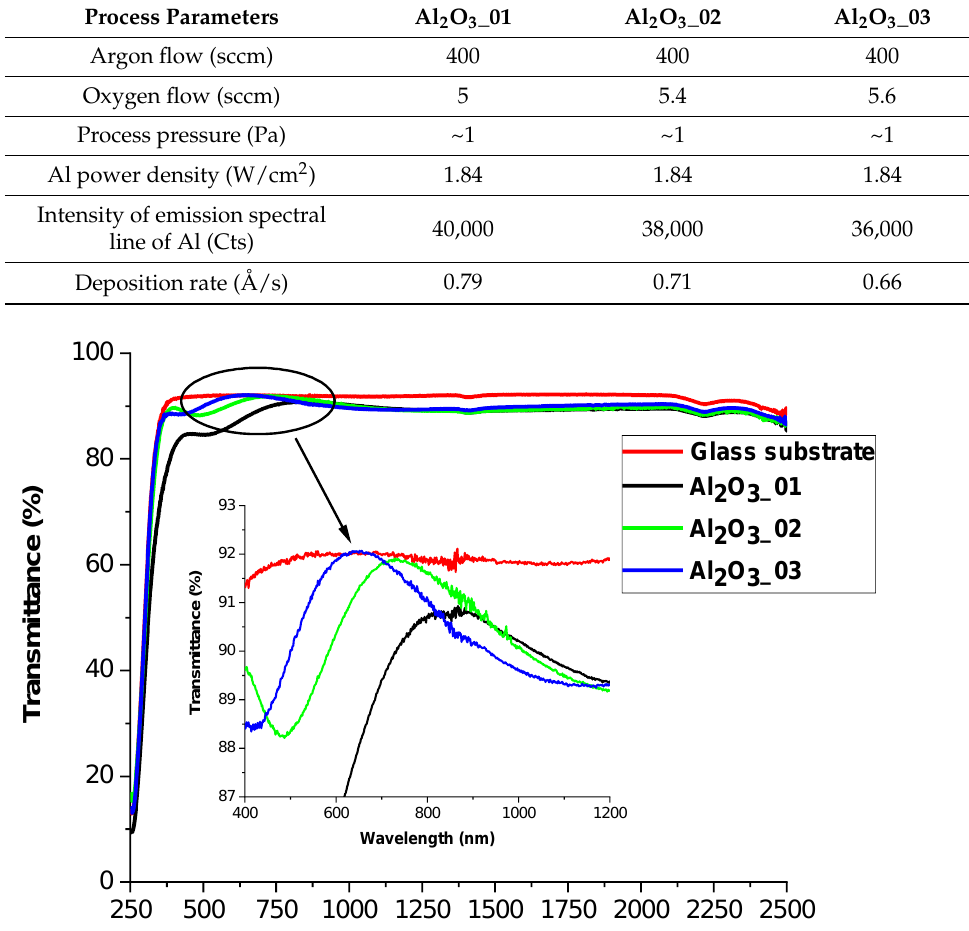
Table 1. Process parameters used to deposit Al 2 O 3 samples.